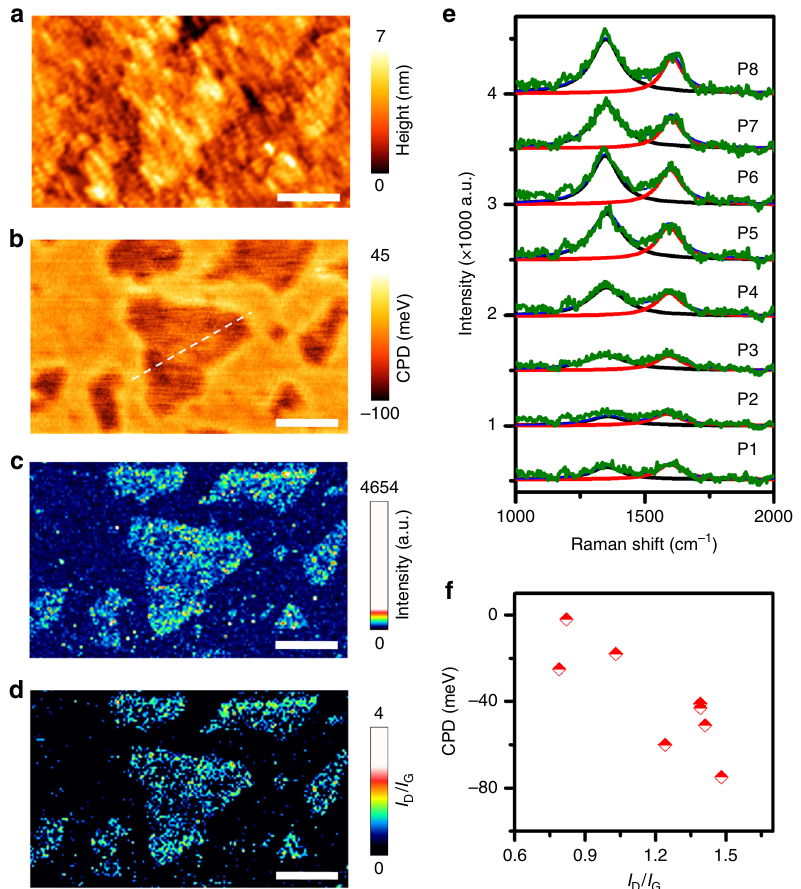
Fig. 4 In situ topographical, chemical and electrical nanoscopy of GO – COOH. a Topography map of a few-layer GO – COOH sample obtained whilst TERS mapping. b CPD map, c TERS map of D band (1350 cm − 1 ) intensity and d I D / I G ratio map measured in the region shown in ( a ). Area: 2.5 × 1.7 µ m 2 . Step size: 16.7 nm. Integration time: 75 ms/pixel. e Averaged TERS spectra from the 8 different locations marked as P1 – P8 in Supplementary Fig. 15 fi tted with two Lorentzian curves. f Plot of CPD as a function of I D / I G ratio calculated from the averaged TERS spectra shown in ( e ) showing an inverse correlation between local defect density and Fermi level on the GO – COOH surface. All scale bars: 500